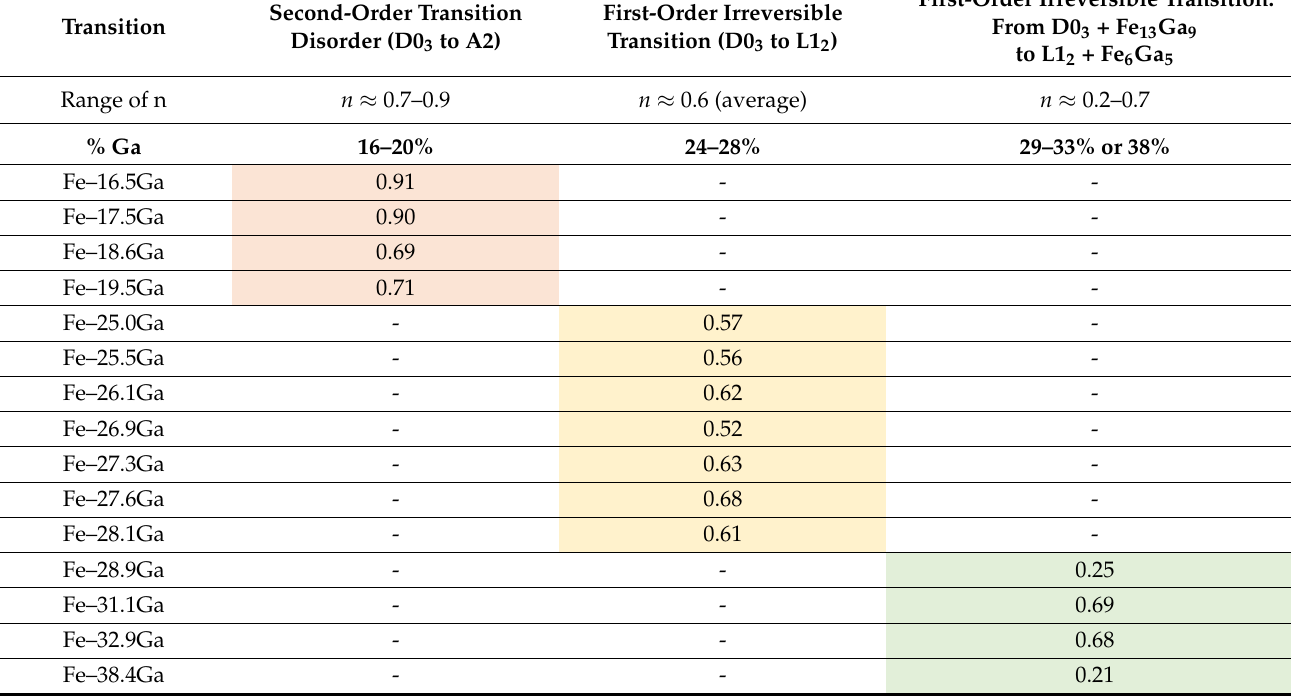
Table 5. The coefficient ( n ) in power dependence Q Tr − 1 ~ 38%)Ga as measured for forced bending